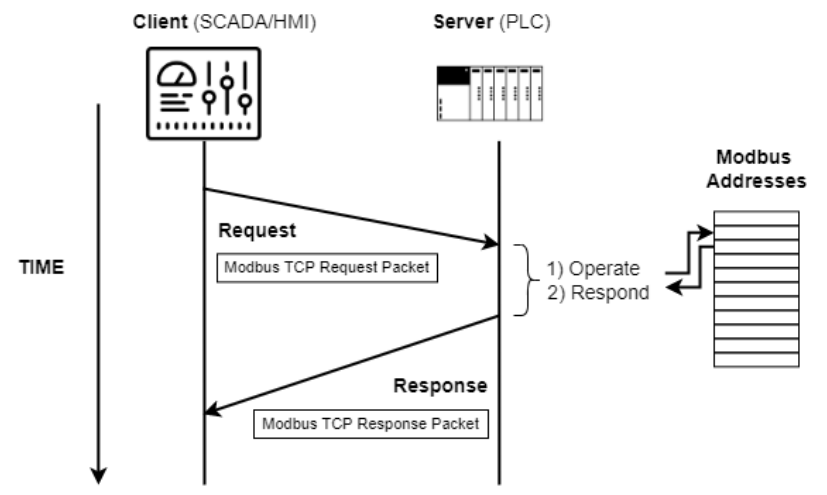
Figure 3. Modbus/TCP client-server communication.